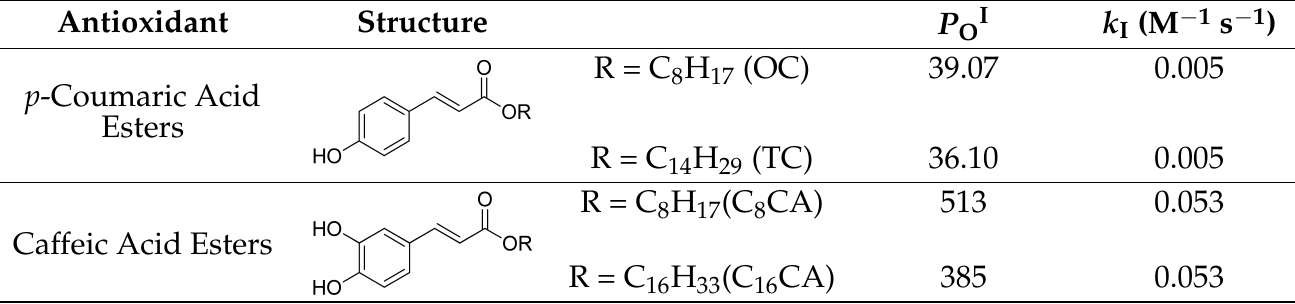
Table 3. Values of the partition constants P OI and of the rate constants in the interfacial region, k I , for the ocyl and tetradecyl esters of p-coumaric and caffeic acids determined in corn oil emulsions stabilized with Tween 20. Values for the caffeic acid esters were obtained from ref.